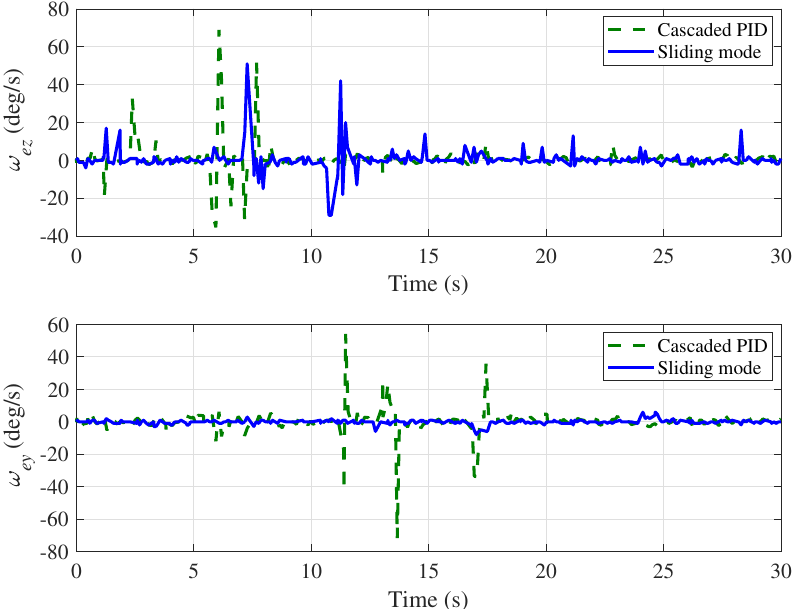
Figure 16. Trajectories of azimuth and elevation angular velocities in experimental